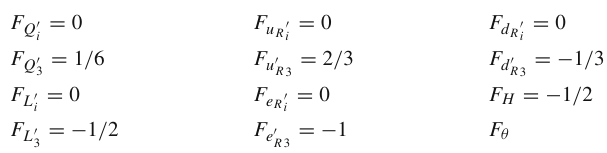
(cid:2) (cid:2) ∼ ( 3 , 2 , 1 / 6 ) , L ∼ ( 1 , 2 , − 1 / 2 ) , u ∼ i i L L R